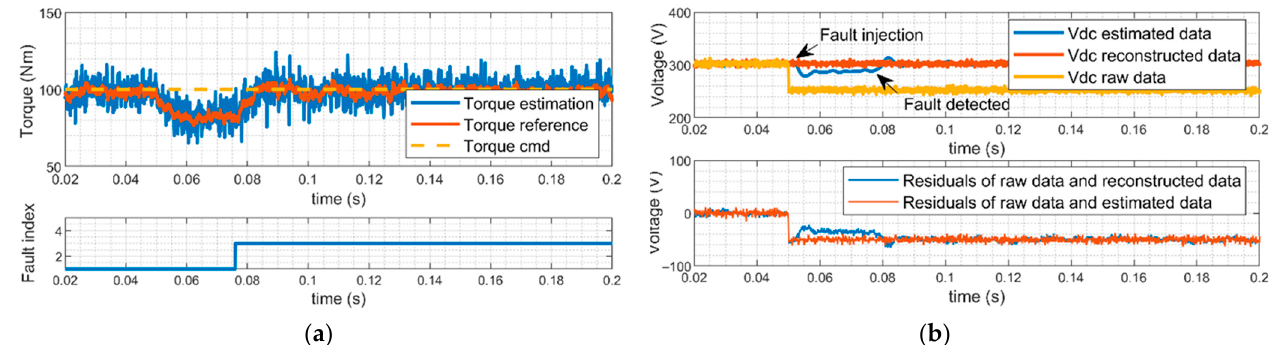
Figure 14. System response of DC bus voltage sensor fault. ( a ) Estimated and reference values of torque; ( b ) DC bus voltage sensor fault.